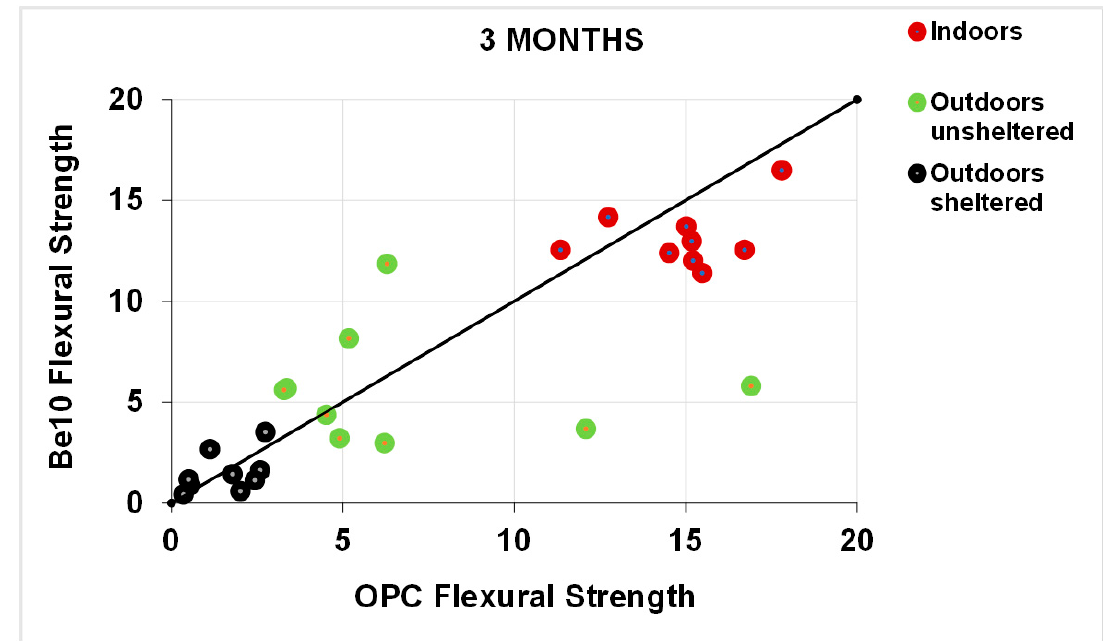
Figure 13. Three-month flexural strength: OPC vs. Be10.